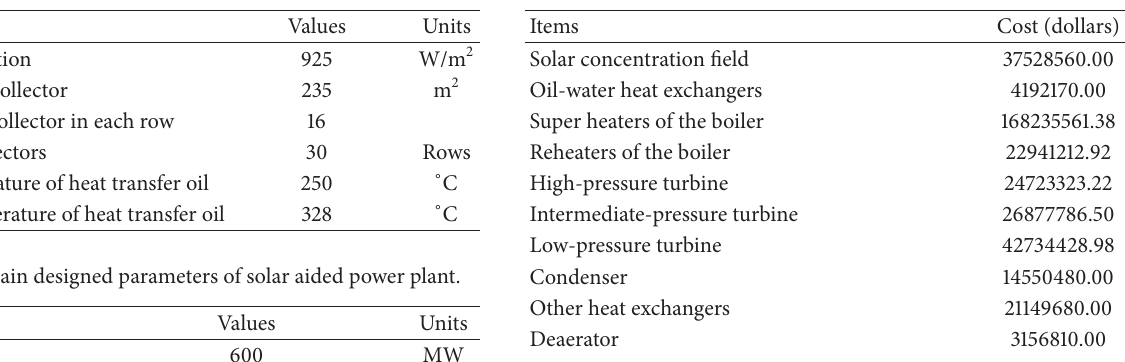
Table 4: The investment of the plant.